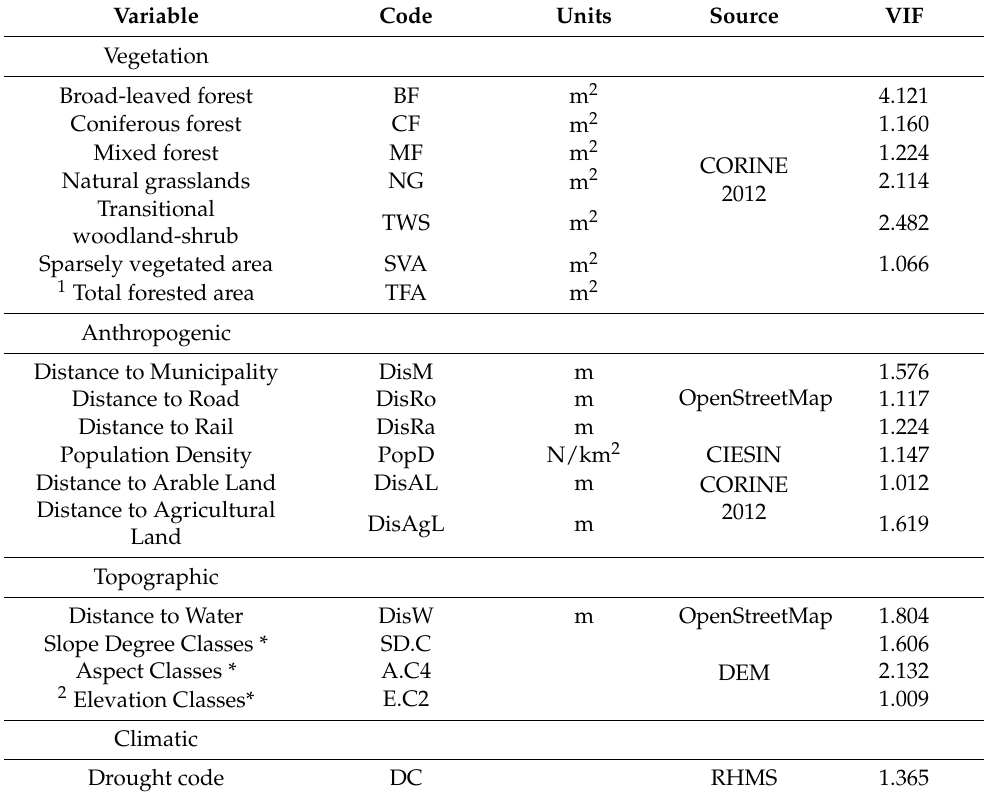
Table 1. Independent variables considered for forest fire occurrence models with codes, units, source and calculated variable inflation factors